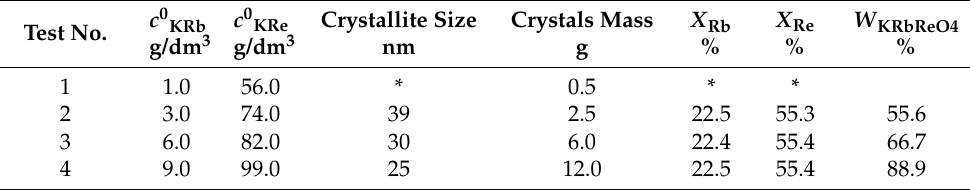
Table 10. Results of the RbReO 4 crystallization tests.